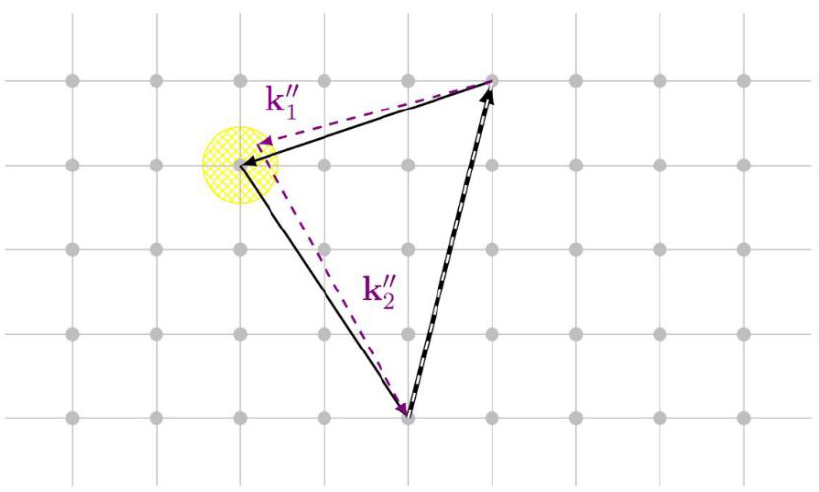
Figure 3. Color online. A resonant triad (black, solid) is shown, as in Figure 1, and an off-grid near-triad (violet, dashed) in its δ —neighborhood (yellow disc, hatched); the two labelled modes do not lie on the lattice, i.e., do not satisfy the original system of PDE and boundary conditions. Here D (cid:54) = 0 can be interpreted as a forcing or a dissipation. It follows that for δ (cid:54) = 0, the wave amplitudes might become larger for the case of exact resonance described by (5): a detuned resonance in the first system may become an exact resonance in the latter and have a larger